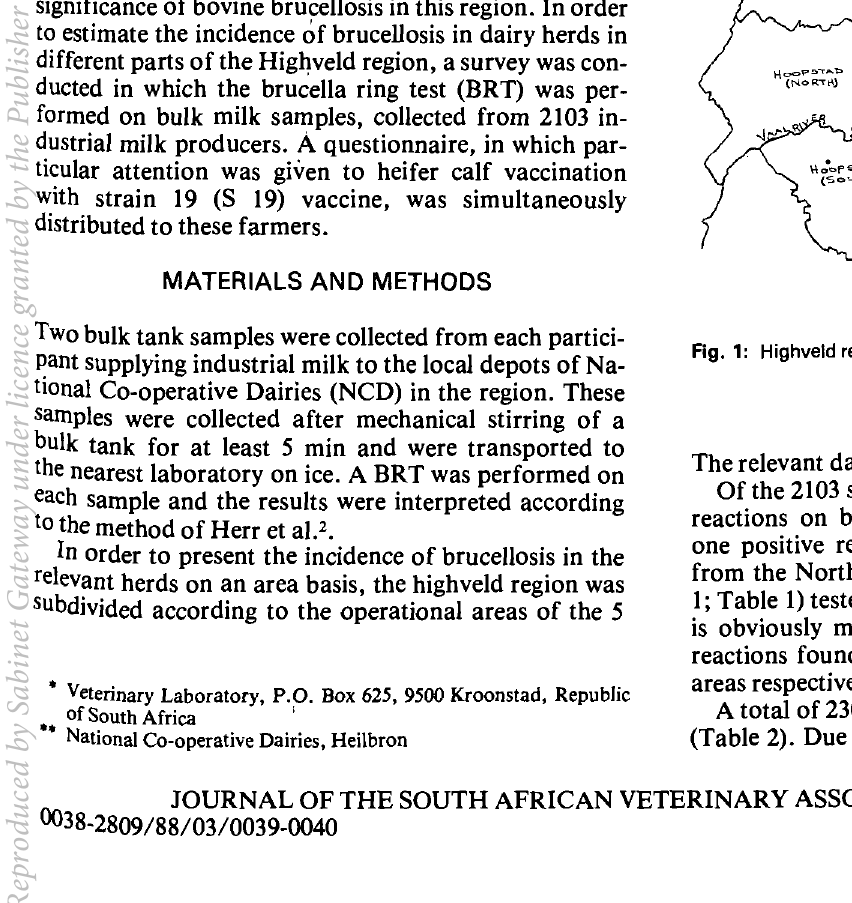
Fig. 1: Highveld region subdivided into 5